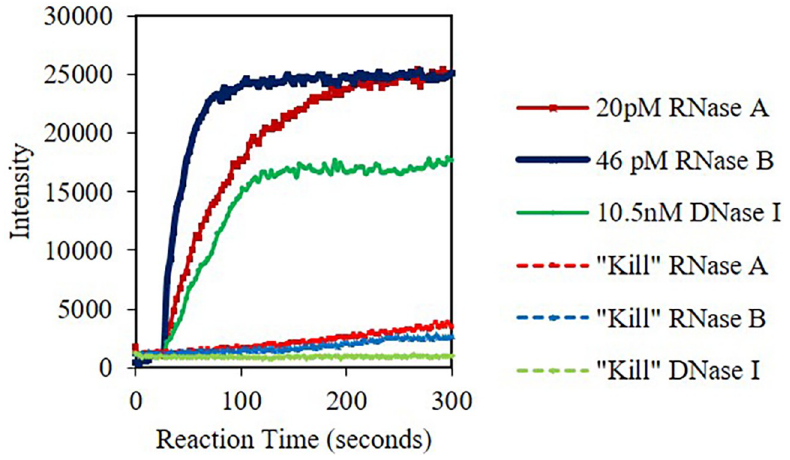
Fig 11. Fluorescent intensity at 520 nm (RNase A/B) and 556 nm (DNase I) versus time for nucleases post Lyse-It. RNase A and B 98% inactivation was achieved through 3 irradiations with Lyse-It of 70% power, 105 seconds. DNase I was 99% inactivated at 50% power for 60 seconds with Lyse-It.